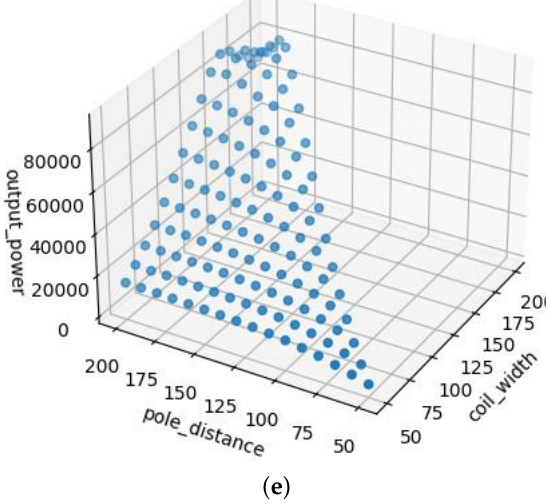
Figure 9. Scatters of grid analysis example. They show the relation amount parameters with